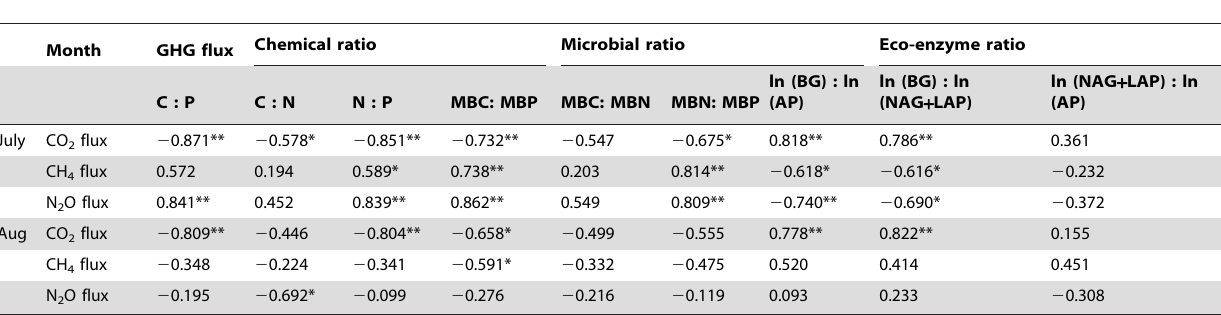
Table 3. Pearson correlation coefficients between CO 2 , CH 4, and N 2 O fluxes of paddy field and soil stoichiometric